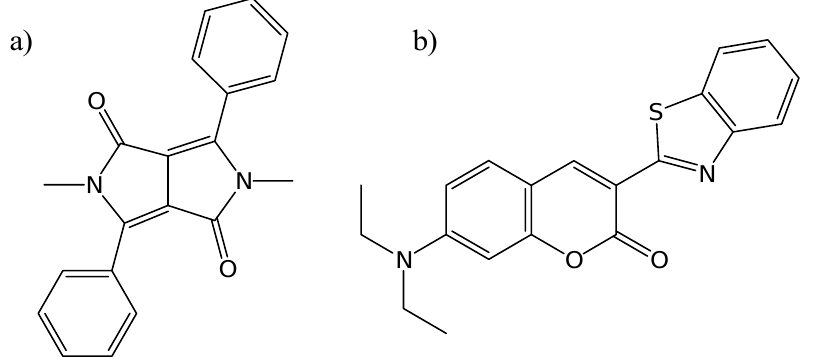
Figure 10 . The chemical structures of the fluorescent probes a) DMDPP and b)